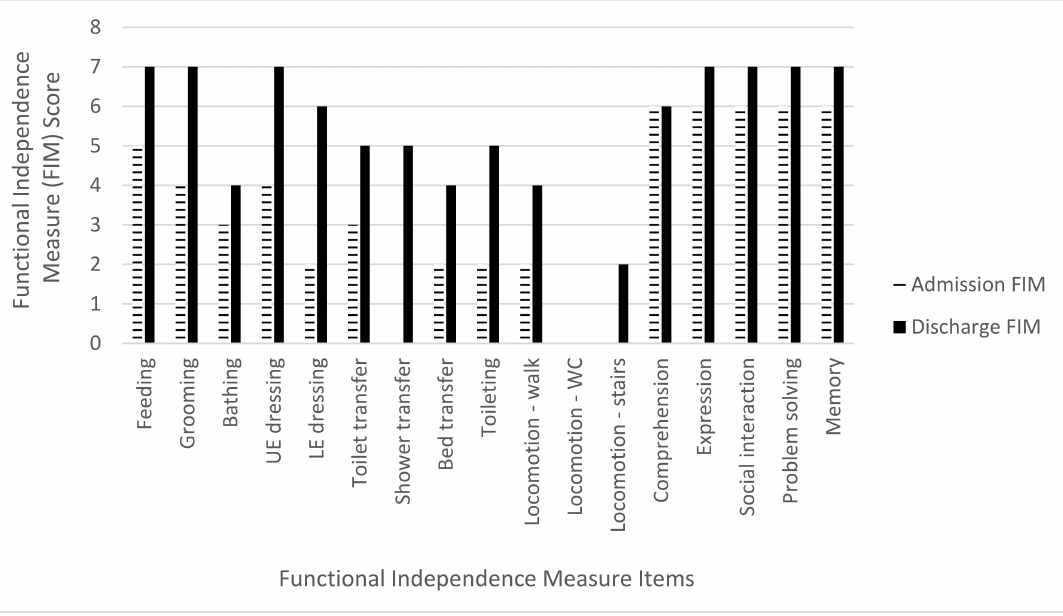
Figure 3. Subject 2 admission and discharge functional independence measure